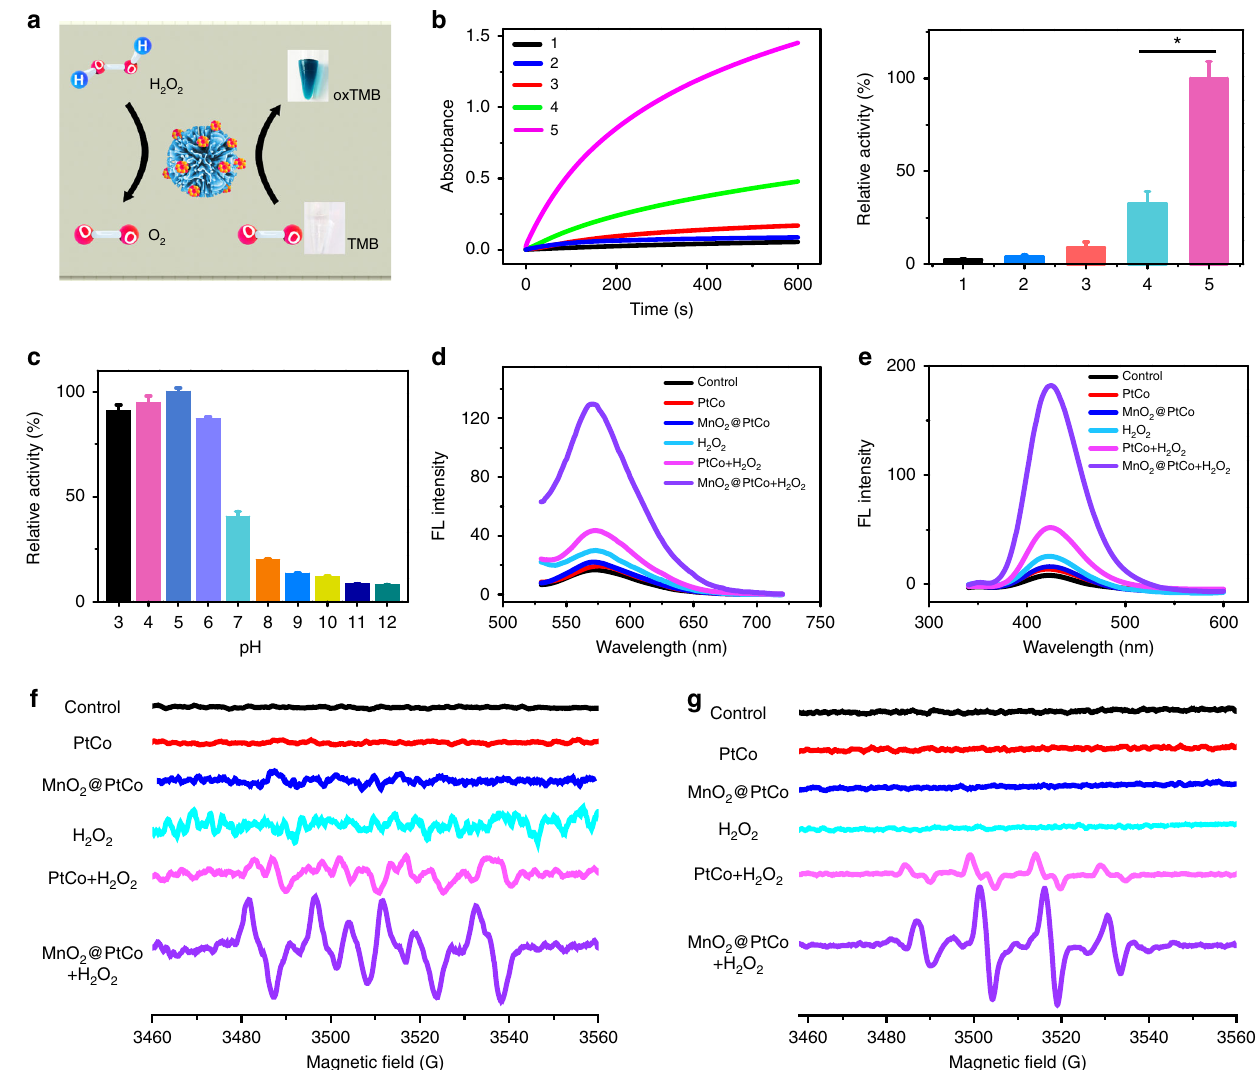
Fig. 3 Multi-enzyme activity and catalytic mechanism of MnO 2 @PtCo nano fl owers in hypoxia. a Schematic illustration of catalytic reactions of MnO 2 @PtCo nano fl owers in the hypoxic H 2 O 2 condition. b The oxidase-like activity of various nanomaterials by monitoring the absorption of TMB at 652 nm and the qualitative analysis of their catalytic activity in the hypoxic H 2 O 2 (100 μ M) environment. 1: H 2 O 2 alone; 2: PtCo; 3: MnO 2 @PtCo; 4: PtCo + H 2 O 2 ; 5: MnO 2 @PtCo + H 2 O 2 . Asterisks indicate signi fi cantly differences ( * P < 0.01, ** P < 0.005, *** P < 0.001), analyzed by unpaired Student ’ s two-sided t test. c The in fl uence of pH on the catalytic ability of MnO 2 @PtCo nano fl owers. d Fluorescence spectra of hydroethidine incubated with MnO 2 @PtCo nano fl owers in the hypoxic H 2 O 2 (100 μ M) condition to demonstrate the presence of O 2 (cid:129) − . e Fluorescence spectra of TA incubated with MnO 2